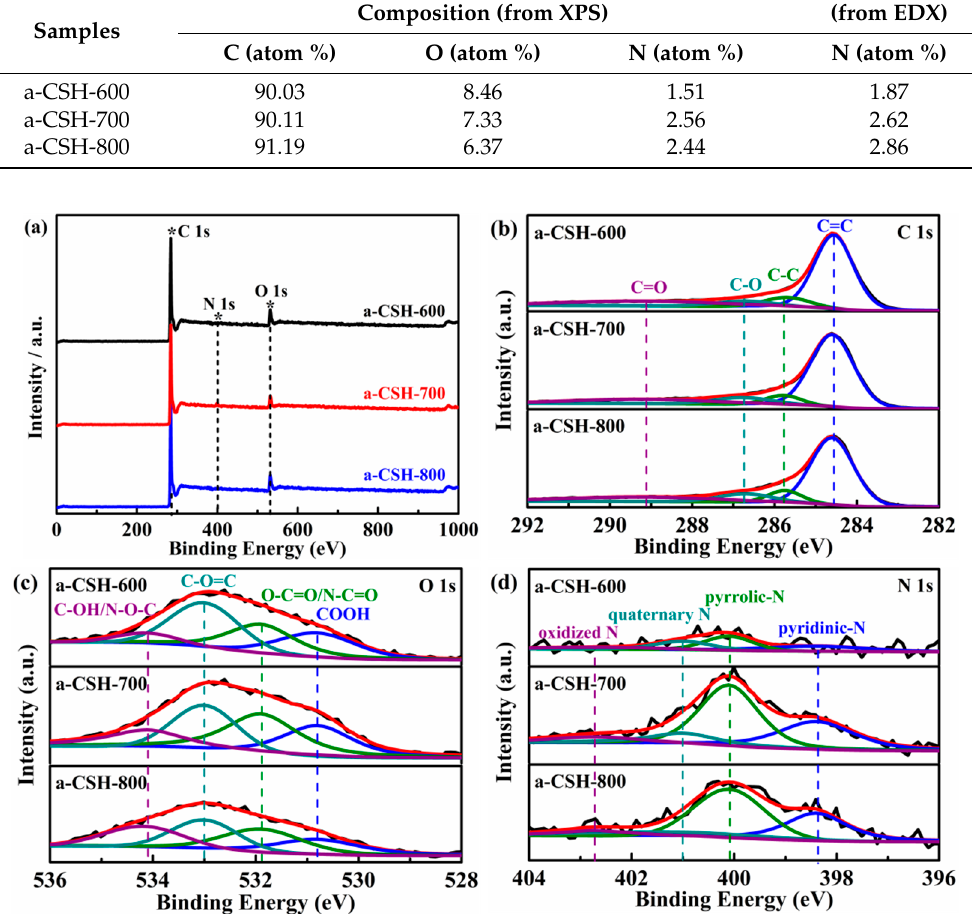
Figure 5. XPS images of the a-CSH-600, a-CSH-700, and a-CSH-800 ( a ). High-resolution C 1s ( b ), O 1s ( c ), and N 1s ( d ) of the a-CSH-600, a-CSH-700, and a-CSH-800.